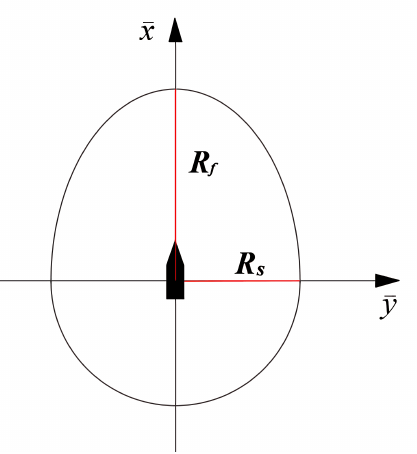
Figure 4. The proposed dynamic navigation ship domain